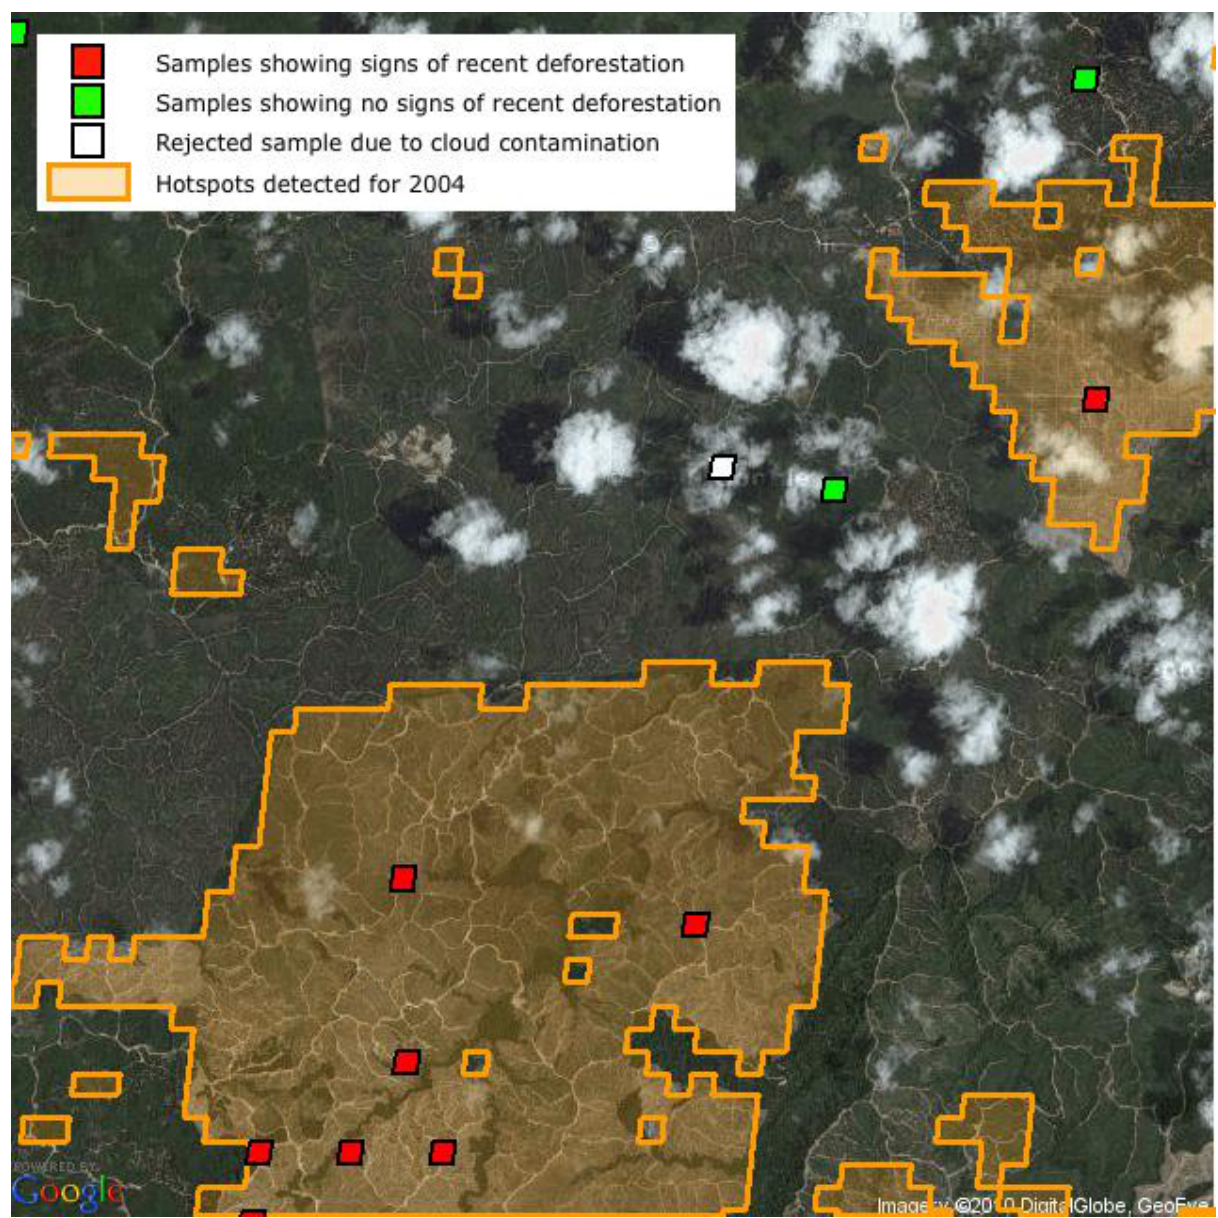
Figure 7. Samples of a Google Earth high-resolution image taken on 27 February 2005 with an overlay of the hotspots detected for the year 2004